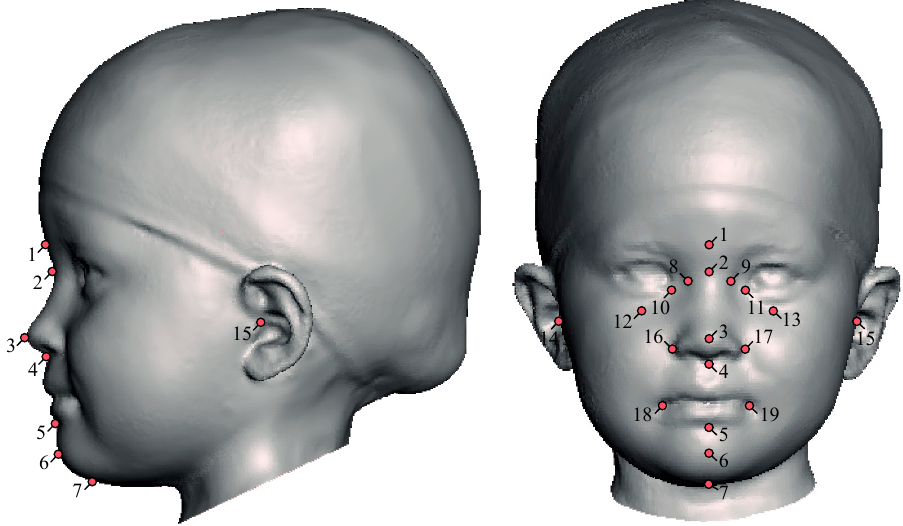
Figure 1. The landmarks included in this study; 1. glabella, 2. sellion, 3. pronasale, 4. subnasale, 5. Sublabiale, 6. Pogonion, 7. menton, 8/9. nasal root point, (right/left), 10/11. endocanthion (right/left), 12/13. infraorbitale (right/left), 14/15. tragion (right/left), 16/17. alare (right/left) and 18/19. cheilion (right/left)